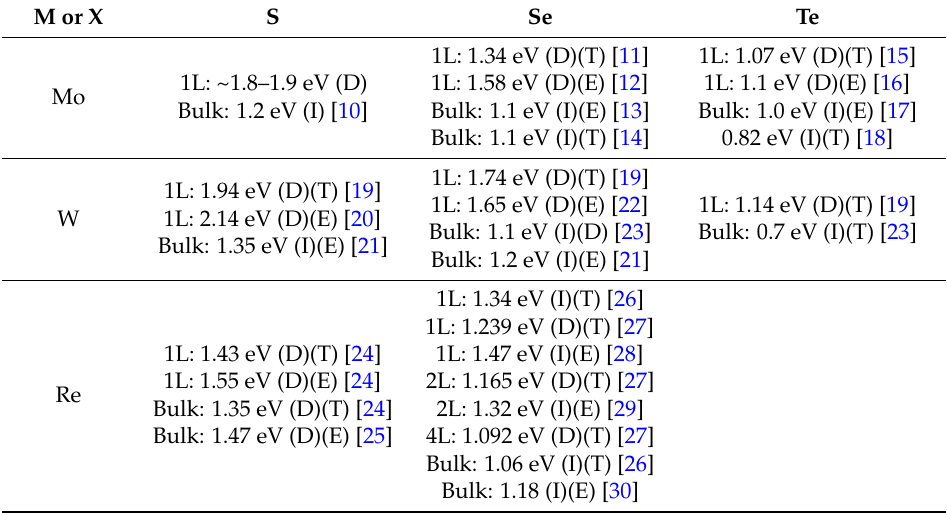
Table 1. Summary of semiconductor TMDCs materials (MX 2 ) and the nature of their band gaps for monolayer (1L) to bulk samples. The direct (D) and indirect (I) bandgaps are as denoted. These values are extracted from both theoretical (T) and experimental (E) study. All data are referring to optical bandgaps at room temperature without considering quasiparticle (e.g., excitons) effects. M or